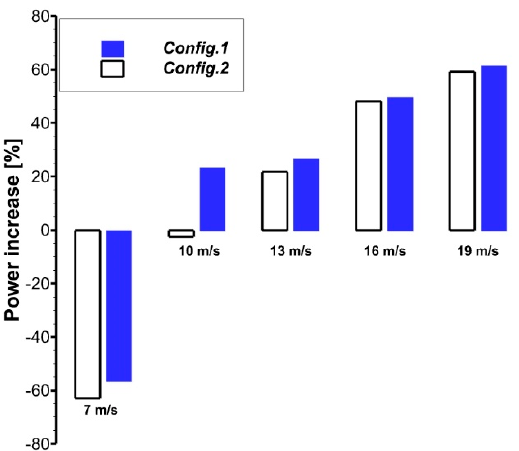
Figure 8. Power increase of configurations 1 and 2 compared to baseline.